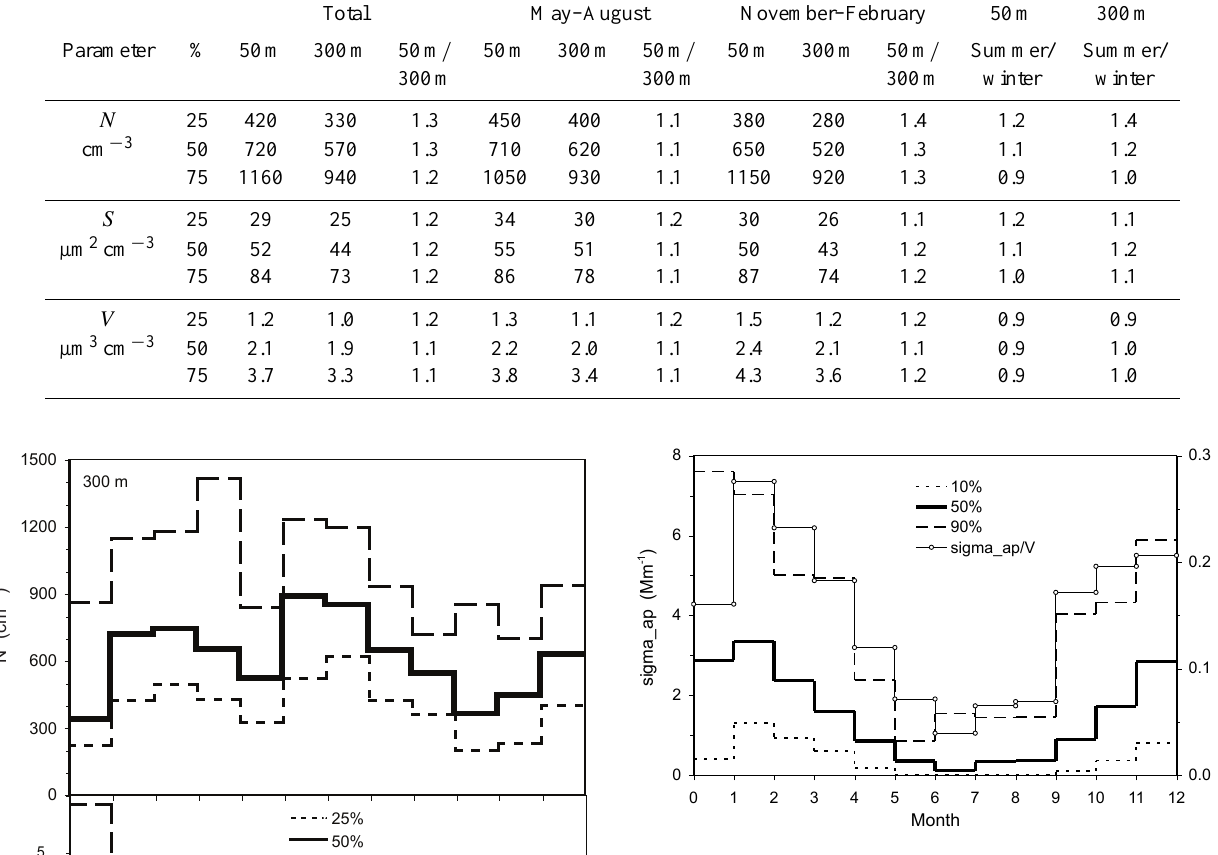
Fig. 3. Monthly percentiles (10, 50, and 90%) of particulate ab- sorption coefficients ( σ ap in Mm − 1 ) at 570nm wavelength in 300m height at ZOTTO, Siberia taken over the time period for the period 9/2006–4/2009; averages of 50m and 300m. The ratio of median σ ap to median volume concentration is depicted as thin line with